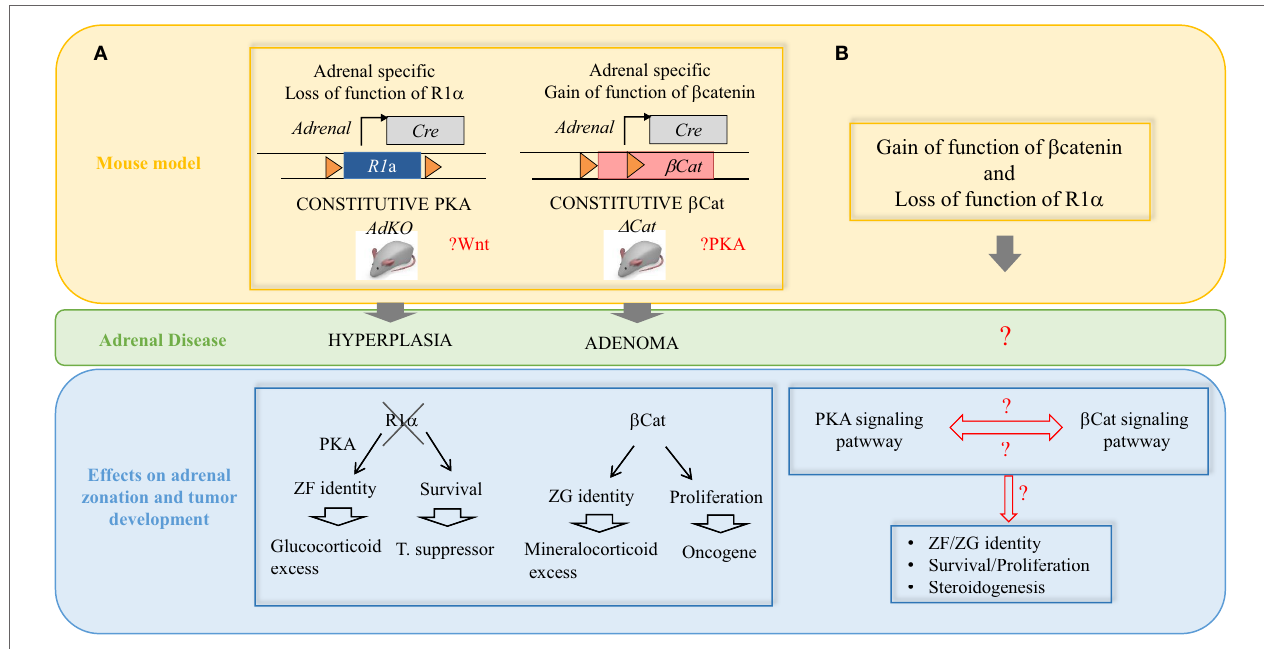
FiGURe 3 | interplay between the wNT/ β -catenin and the cAMP/PKA pathways in the pathogenesis of adrenal hyperplasias and tumors . (A) Two mouse models recapitulating some of the most frequent alterations found in adrenal tumors in patients. AdKO mice developed cortical hyperplasia as a result of constitutive PKA activation due to gene inactivation of R1a regulatory subunit of PKA. The increased PKA signaling also favored zona fasciculata cell identity and glucocorticoid excess. Δ Cat mice developed cortical adenoma as a result of constitutive b-catenin due to deletion of exon 3 in the gene encoding the b-catenin ( Ctnnb1) leading to protein stabilization. Increased b-catenin activation also induced ectopic differentiation of zona glomerulosa and aldosterone excess . (B) Our models demonstrated that Prkar1a is a tumor suppressor and Ctnnb1 is an adrenal oncogene but secondary genetic alterations are required for malignant progression. A possible interplay between the WNT/ β -catenin and the cAMP/PKA pathways in the adrenal cortex zonation and tumorigenesis is an important point to further investigate. The question can be genetically addressed by using compound transgenic mice based on previous available models and carrying both β -catenin and PKA constitutive